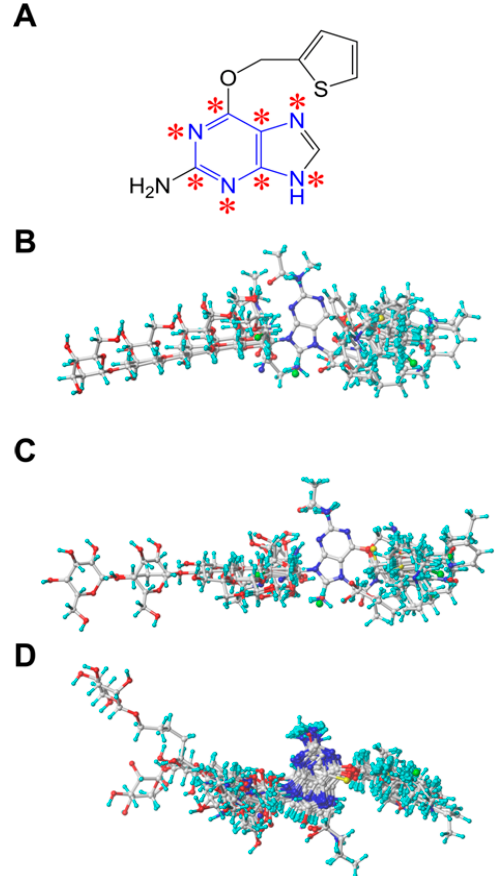
Figure 6. ( A ) Structure of the template molecule (compound 45 ) used for the alignment. The common substructure atoms are marked with asterisks. Alignments of all molecules using ( B ) ligand-based, ( C ) DFT optimization-based and ( D ) docking-based alignment method.